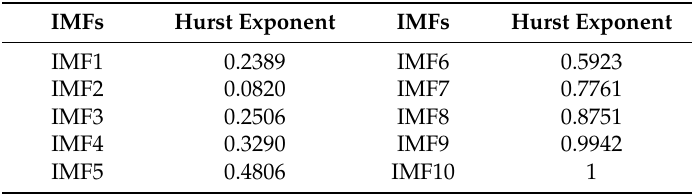
IMF6 results. ( b ) IMF7–IM10 and residue results. Table 3. Calculation results of the Hurst exponent. Table 3. Calculation results of the Hurst exponent.